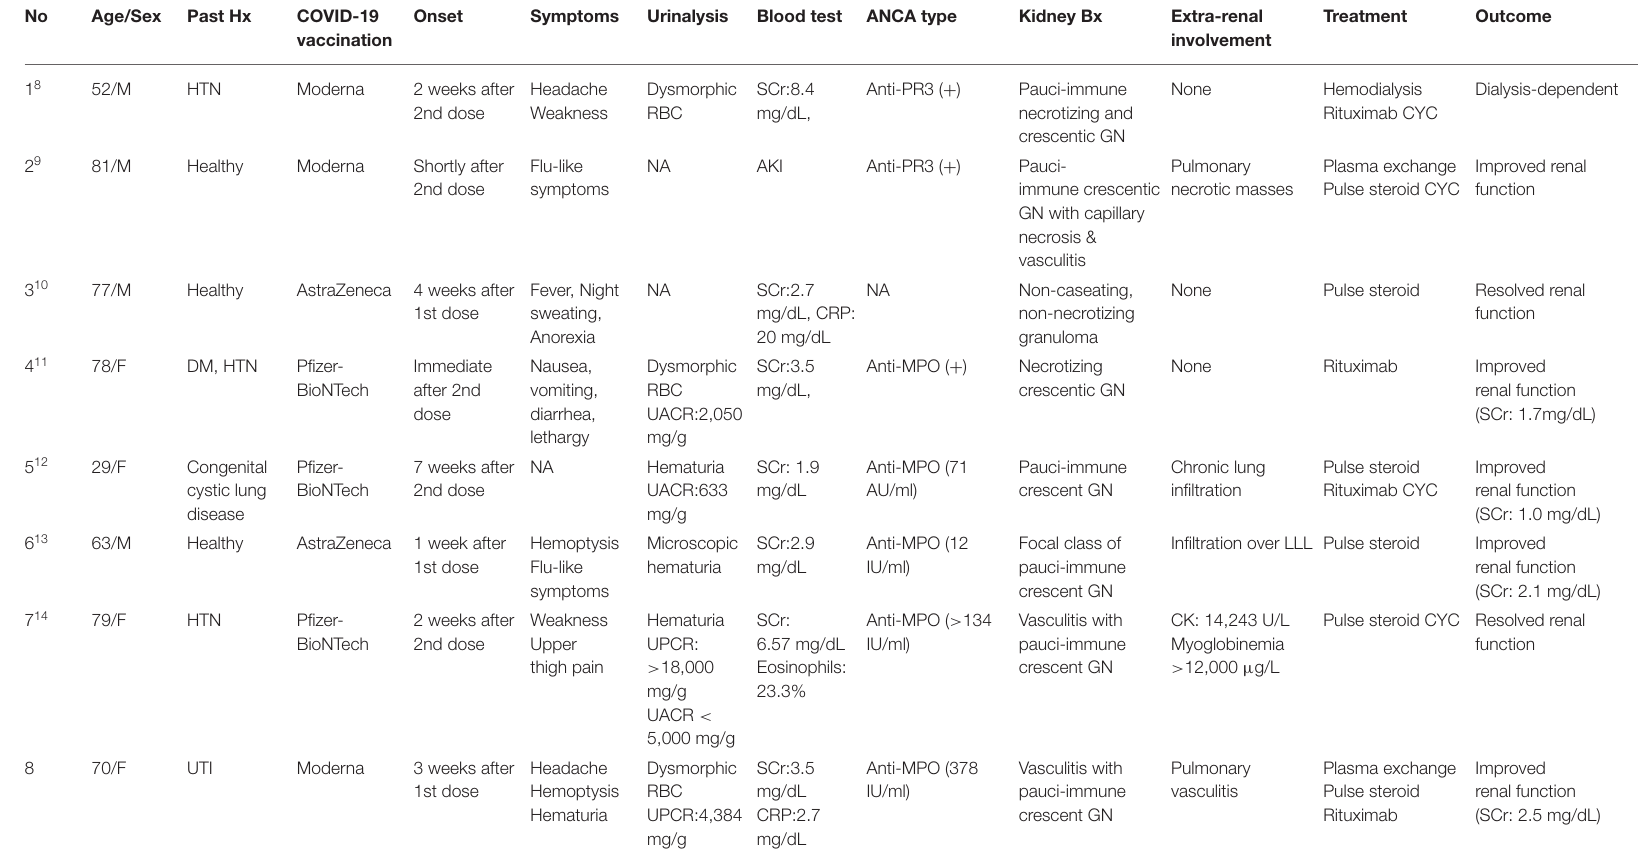
TABLE 1 | AAV with RPGN following COVID-19